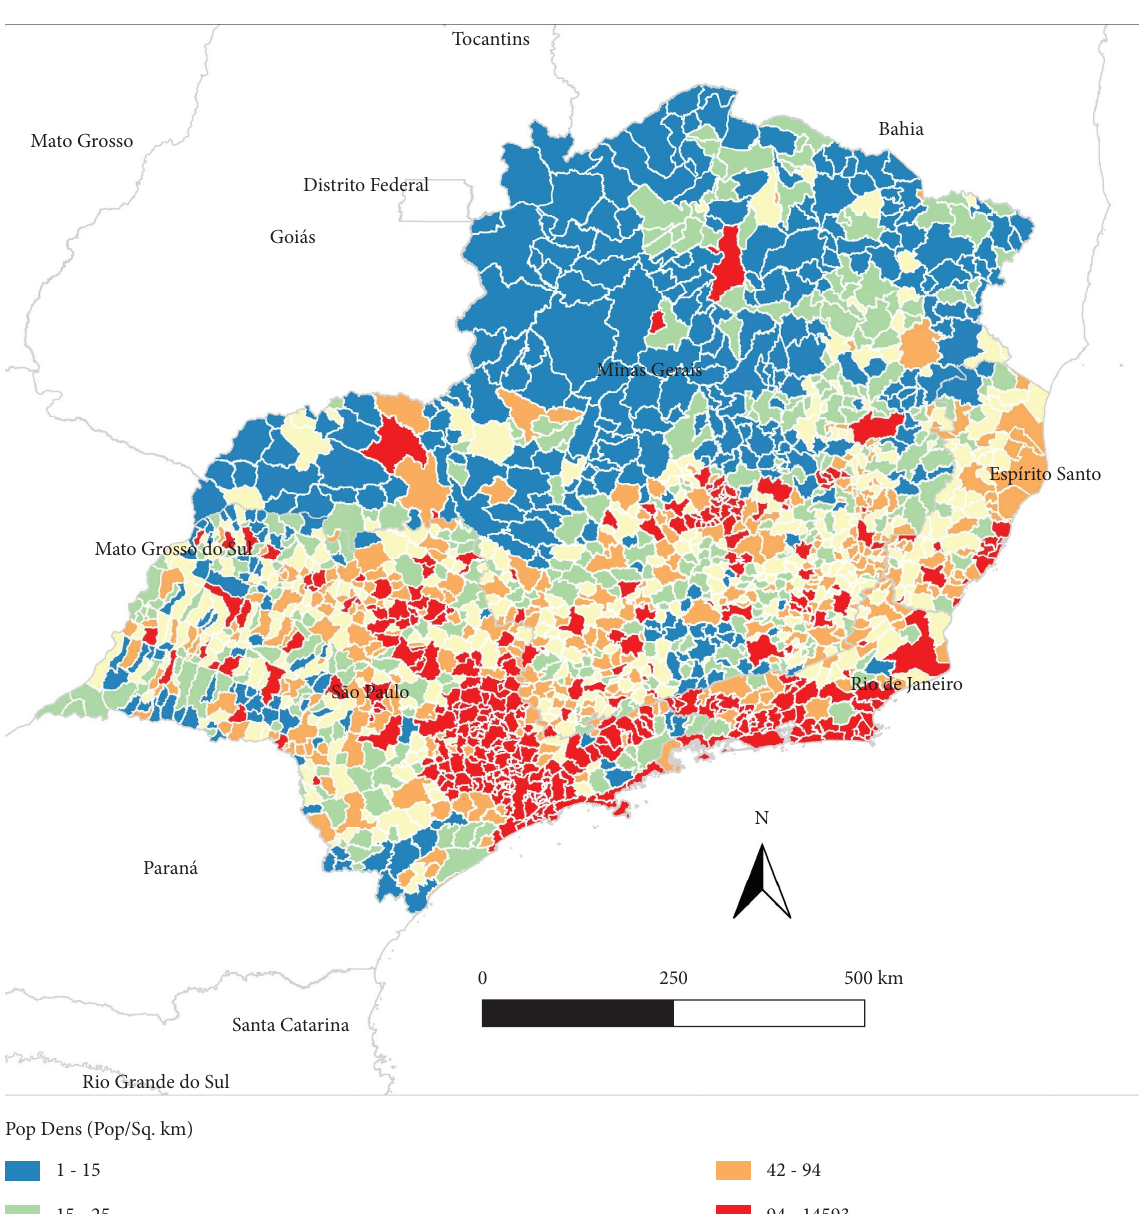
Figure 2: Population density of municipalities in Southeast Brazil. Source: IBGE